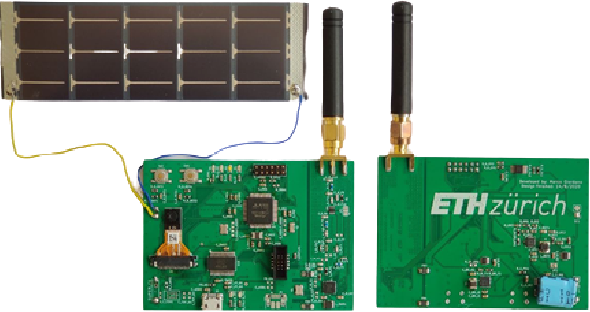
Figure 8. Face detection sensor system based on IoT